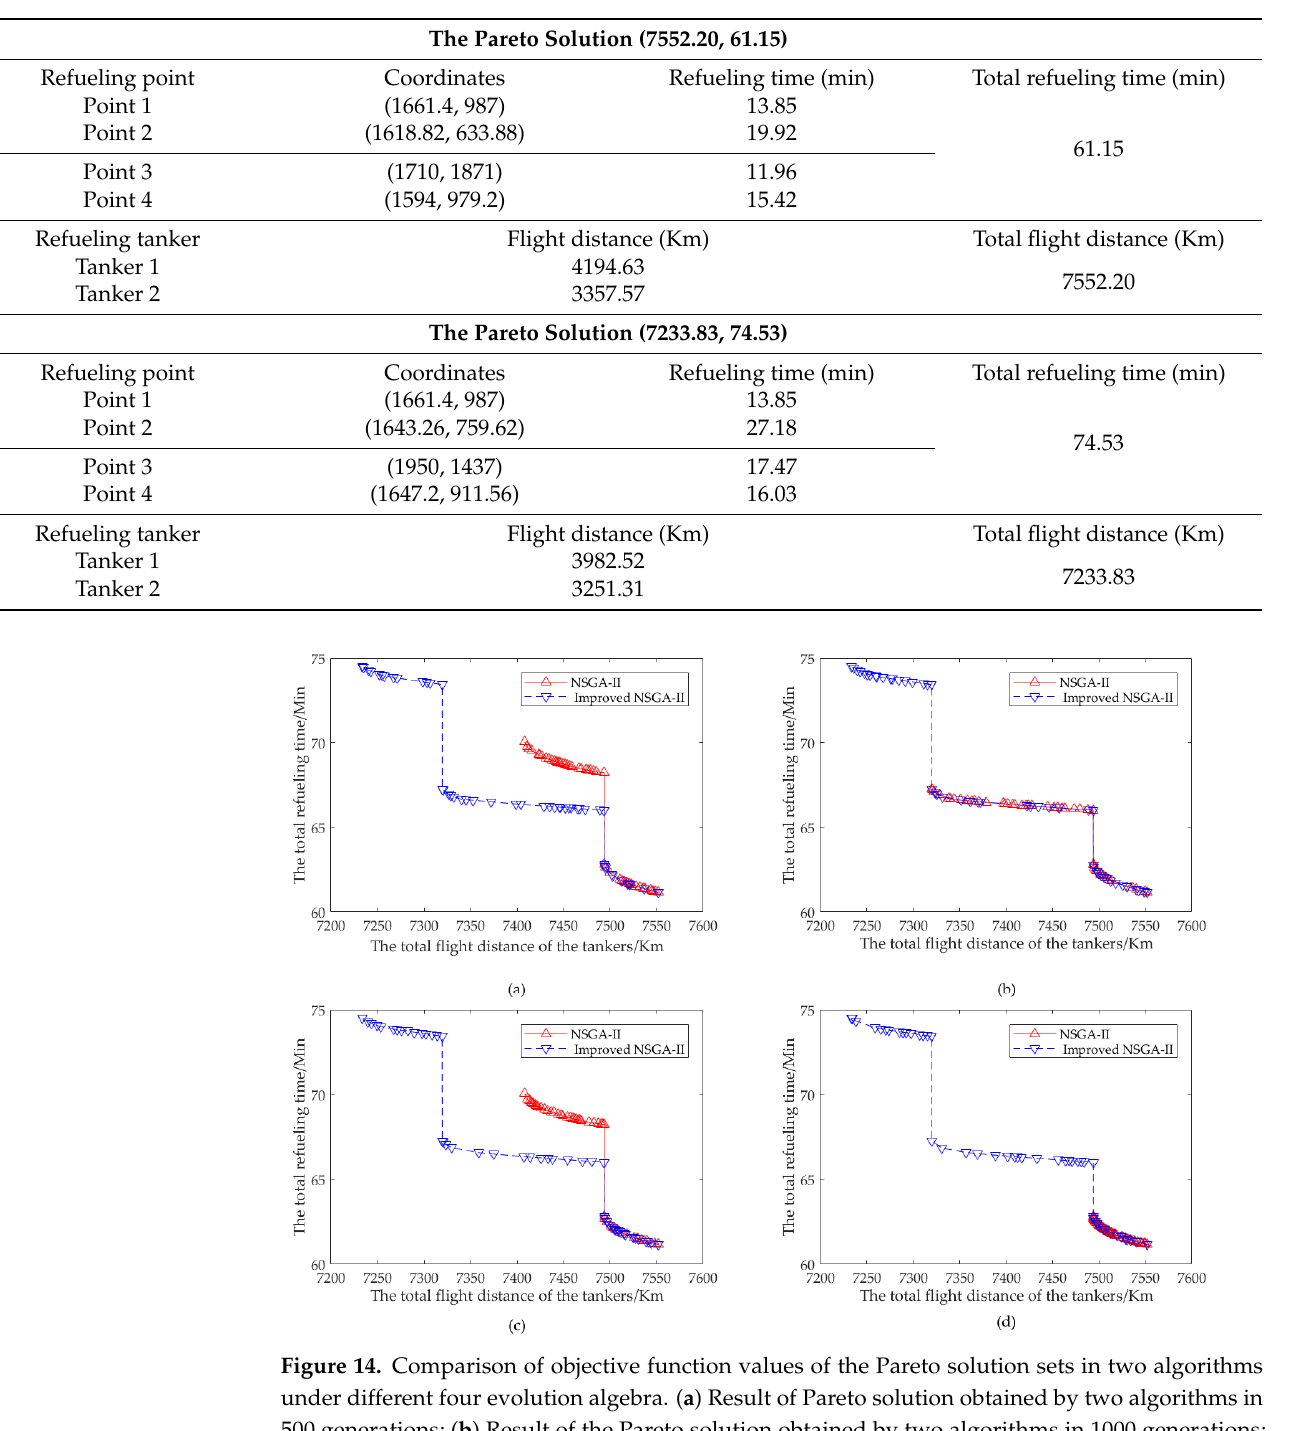
Table 5. Detailed information about the Pareto solution of infinite crowding distance obtained by improved NSGA-II.